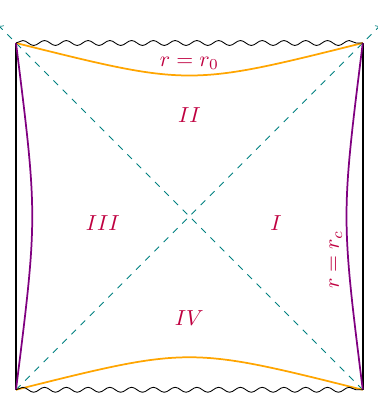
Figure 1: Penrose diagram of an eternal black brane. The UV cutoff is denoted by r and the cutoff behind the horizon is denoted by r